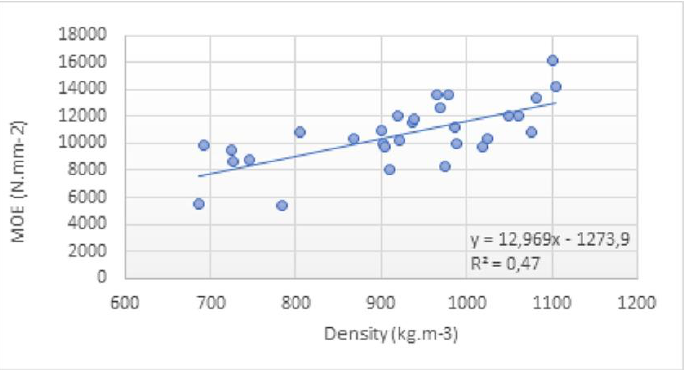
Figure 6. Correlations between MOE and density for all sites.